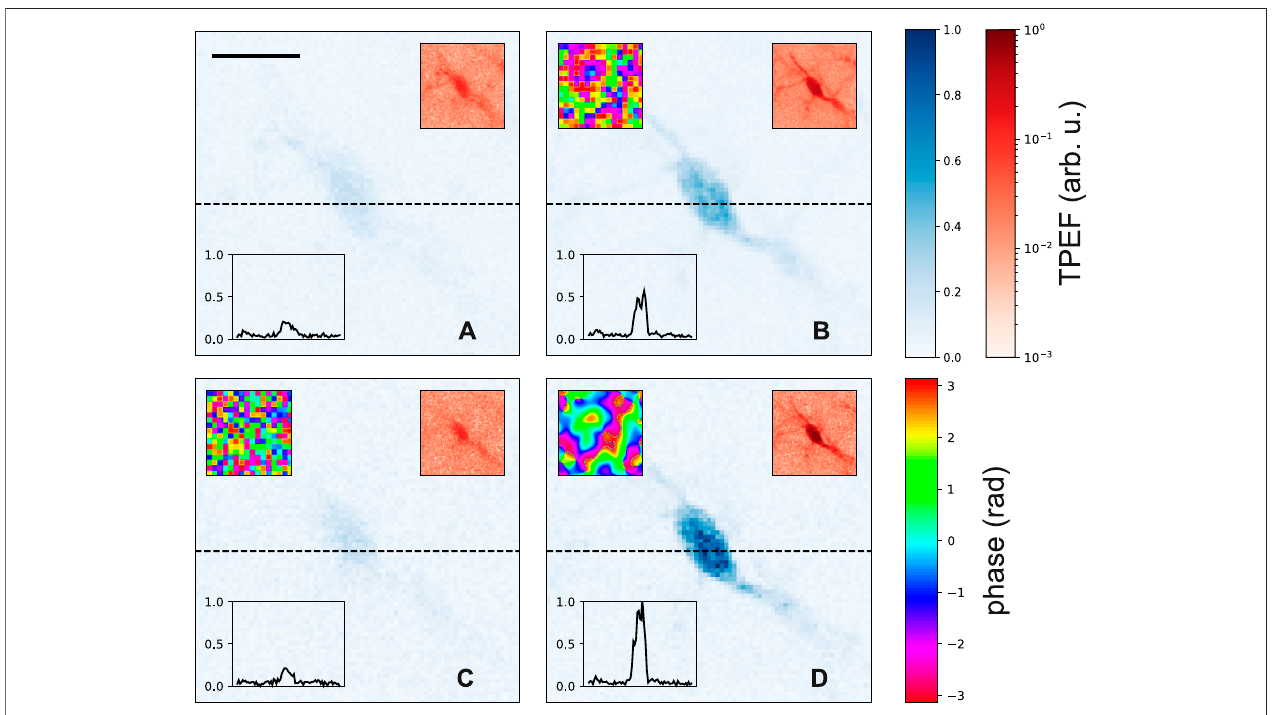
FIGURE 5 | Image enhancement for a biological sample. Murine striatal microglia expressing green fl uorescent protein, 200 μ m deep inside fi xed brain tissue. Image (A) was recorded without AO scattering correction. (B – D) show the same cell after correction (3 iterations of 256 modes) for scattering in the tissue above: (B) = a-CSA, (C) = regular CSA, (D) = DASH. Upper left insets (if present) show the applied scatter compensation mask; lower left insets show the TPEF along the black, dashed line. Main panels are in (blue) linear color scale, upper right insets show the same image data as the respective main panels in logarithmic (red) color scale. The size of the scalebar in (A) corresponds to 10 μ